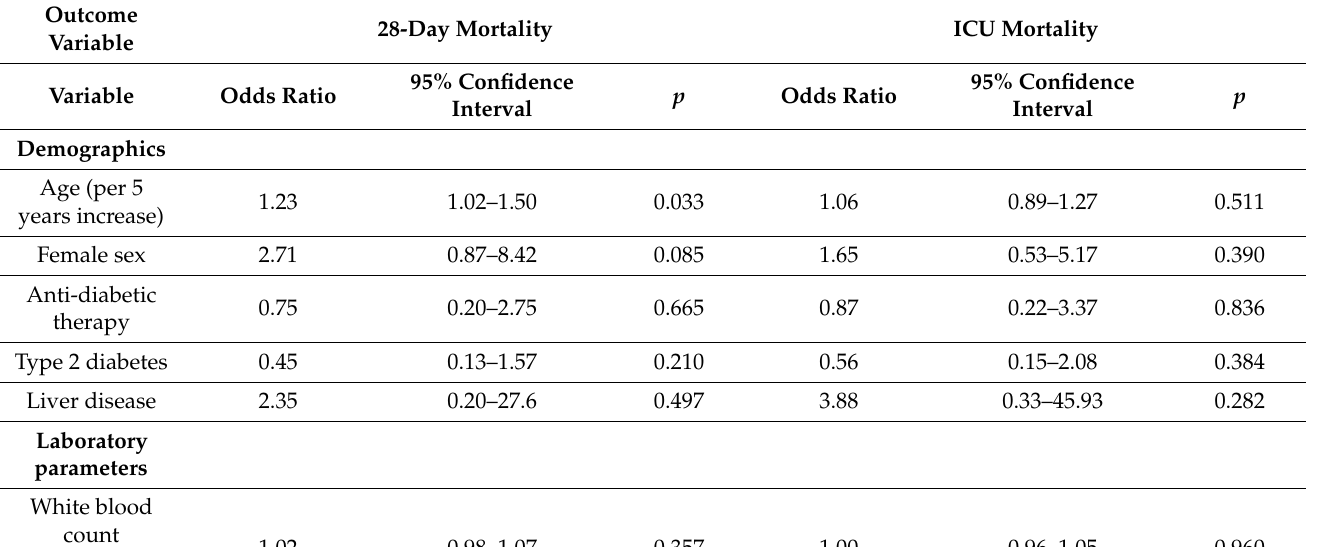
Table 5. Univariable logistic regression models in sepsis patients for prediction of 28-day and ICU